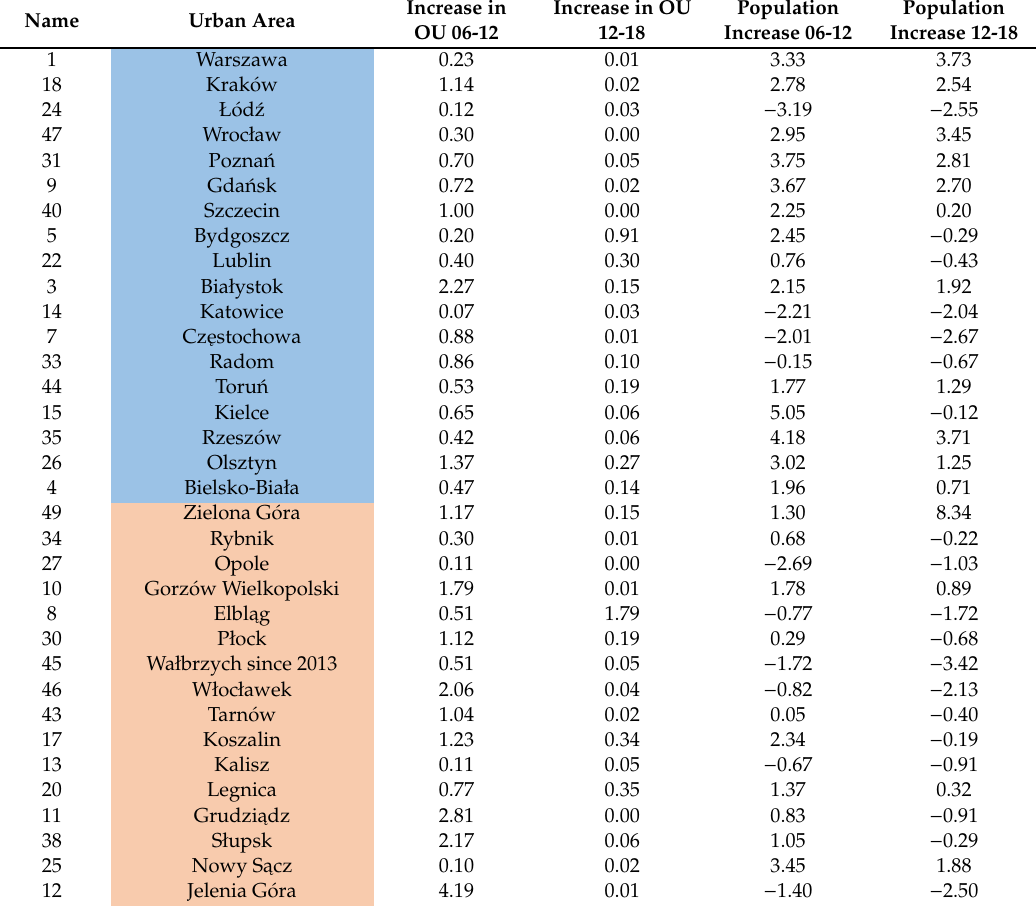
Table A5. RankingofcitiesbasedonanincreaseinthevaluesoftheOUindexandanincreaseinpopulation. Demographic classes of cities have been marked in color. Big cities—blue, medium—orange,